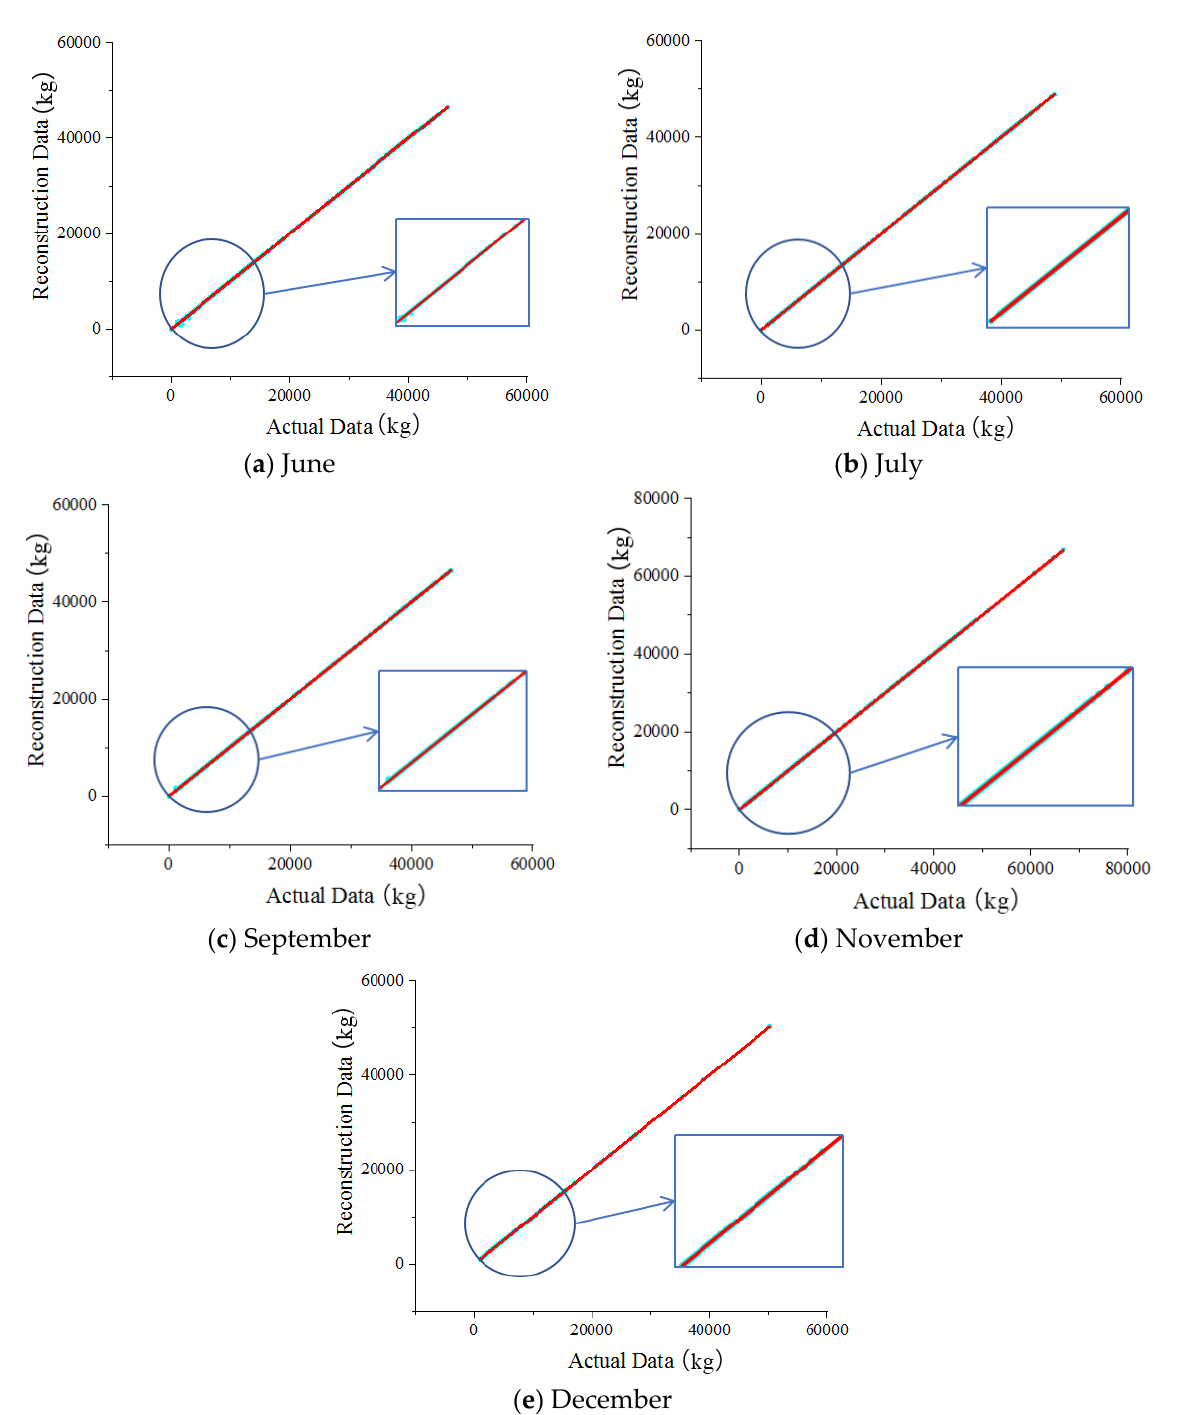
Figure 6. The comparison of the gross vehicle weight data. In Figure 6, the horizontal and vertical coordinates represent the actual data and the re- constructed data, respectively, and the scatter points in the figure are uniformly distributed over the image of y = x for two weeks, which demonstrates that the proposed model reconstructed the gross vehicle weight data adequately. Furthermore, there is a good agree- ment between the actual data and the reconstructed data. Thus, the proposed GAN could accurately capture and reconstruct the trained dataset’s potential features and distribution patterns. Figure 7 shows the results of the training loss of the generator